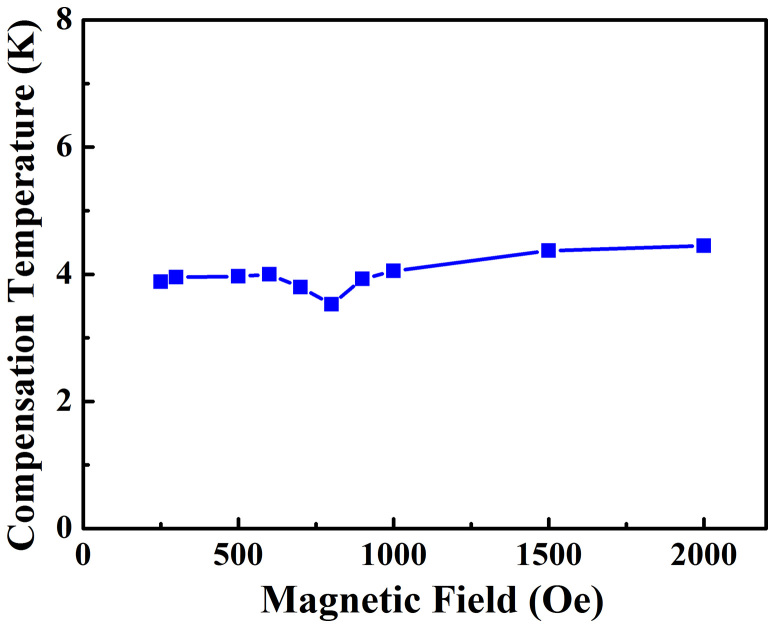
Magnetic field dependence of compensation temperature of SmFeO3 single crystal.